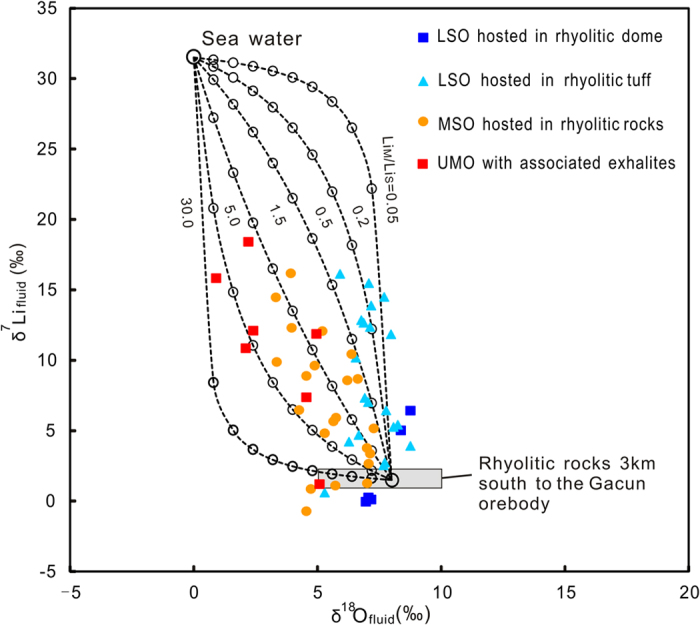
Oxygen-lithium isotopic compositions of the ore-forming fluids at Gacun, which can be reproduced by mixing of variable amounts of seawater (δ18O = +0‰; δ7Li = +31.5‰) with a magmatic fluid (δ18O = +8‰; δ7Li = +1.5‰) with variable Limagmatic/Liseawater mass mixing ratios.Dot-lines with open-circles (10% interval) show a binary mixing between magmatic fluid and seawater. Lim/Lic refers Li concentration ratios in magmatic fluid and seawater. Modeling calculation sees Appendix II.